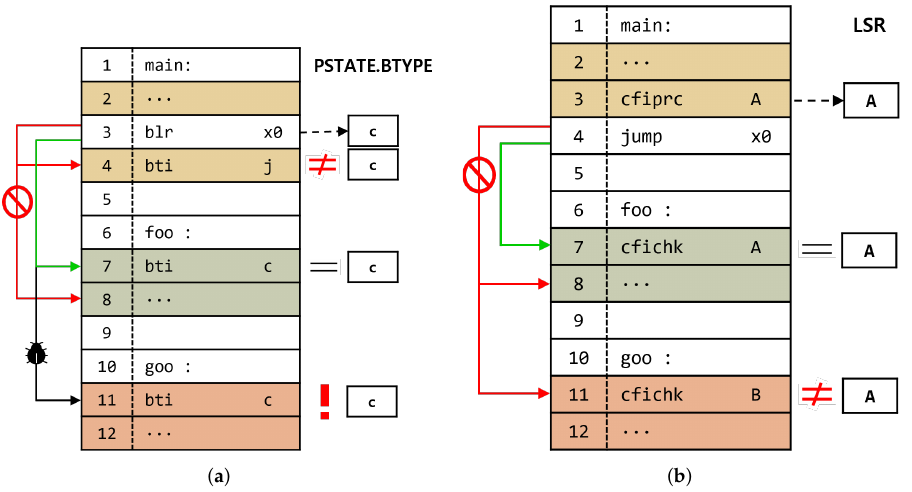
Figure 1. Simple example for ARM BTI [4] and SWT [6]. Assume that the indirect call in the main function is intended to invoke the foo function: ( a ) ARM BTI; and ( b )